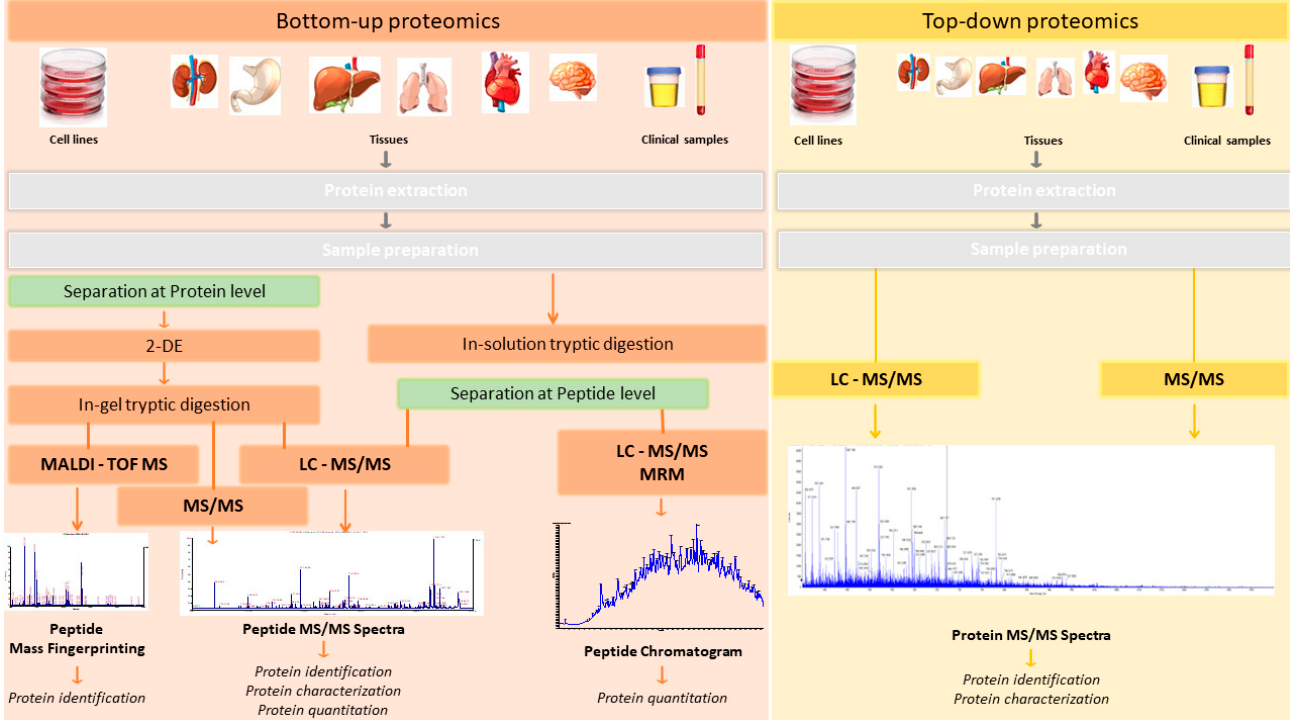
Figure 1. “Bottom-up” and “top-down” Proteomic Strategies in clinical samples. In “bottom-up” proteomics approaches, proteins are processed with an exogenous protease (e.g., trypsin), producing internal peptides that have adequate properties for LC MS/MS and database searches, including length, ionization, and fragmentation parameters. These peptides can be analyzed by shotgun proteomics methods to identify the parent protein based on the endogenous cleavage site, and thereby identify the protein itself. By contrast, top-down proteomics permits both strategies: protein cleavage with proteases and direct protein identification without cleavage.